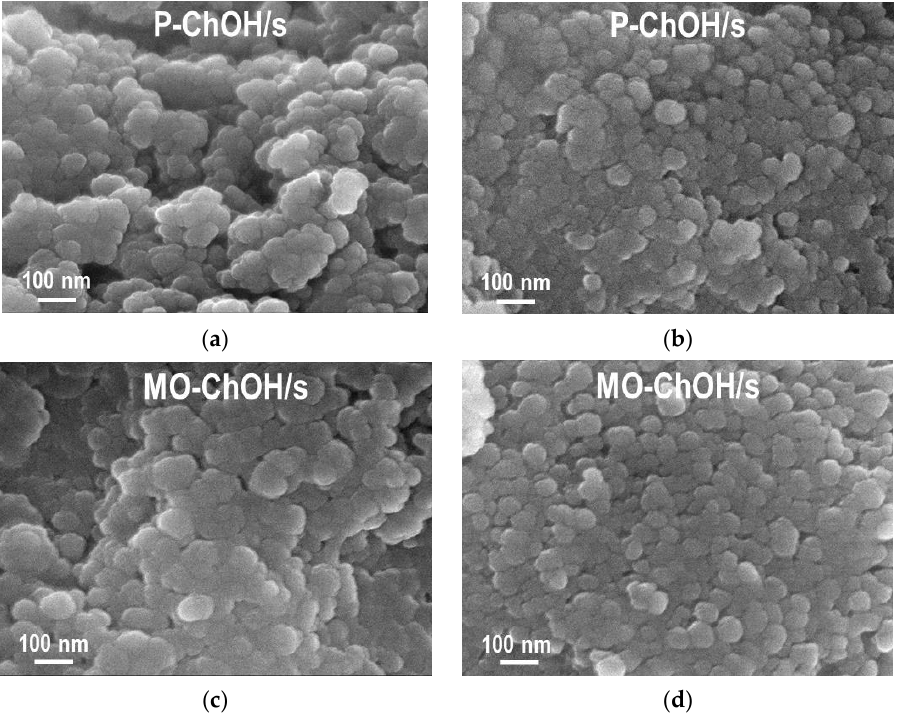
Figure 4. SEM images of precursors and calcined mixed-oxide materials obtained with ChOH pre- cipitant, without or with starch: ( a ) P-ChOH; ( b ) P-ChOH/s; ( c ) MO-ChOH; ( d ) MO-ChOH/s. Mag- nification × 10,000.